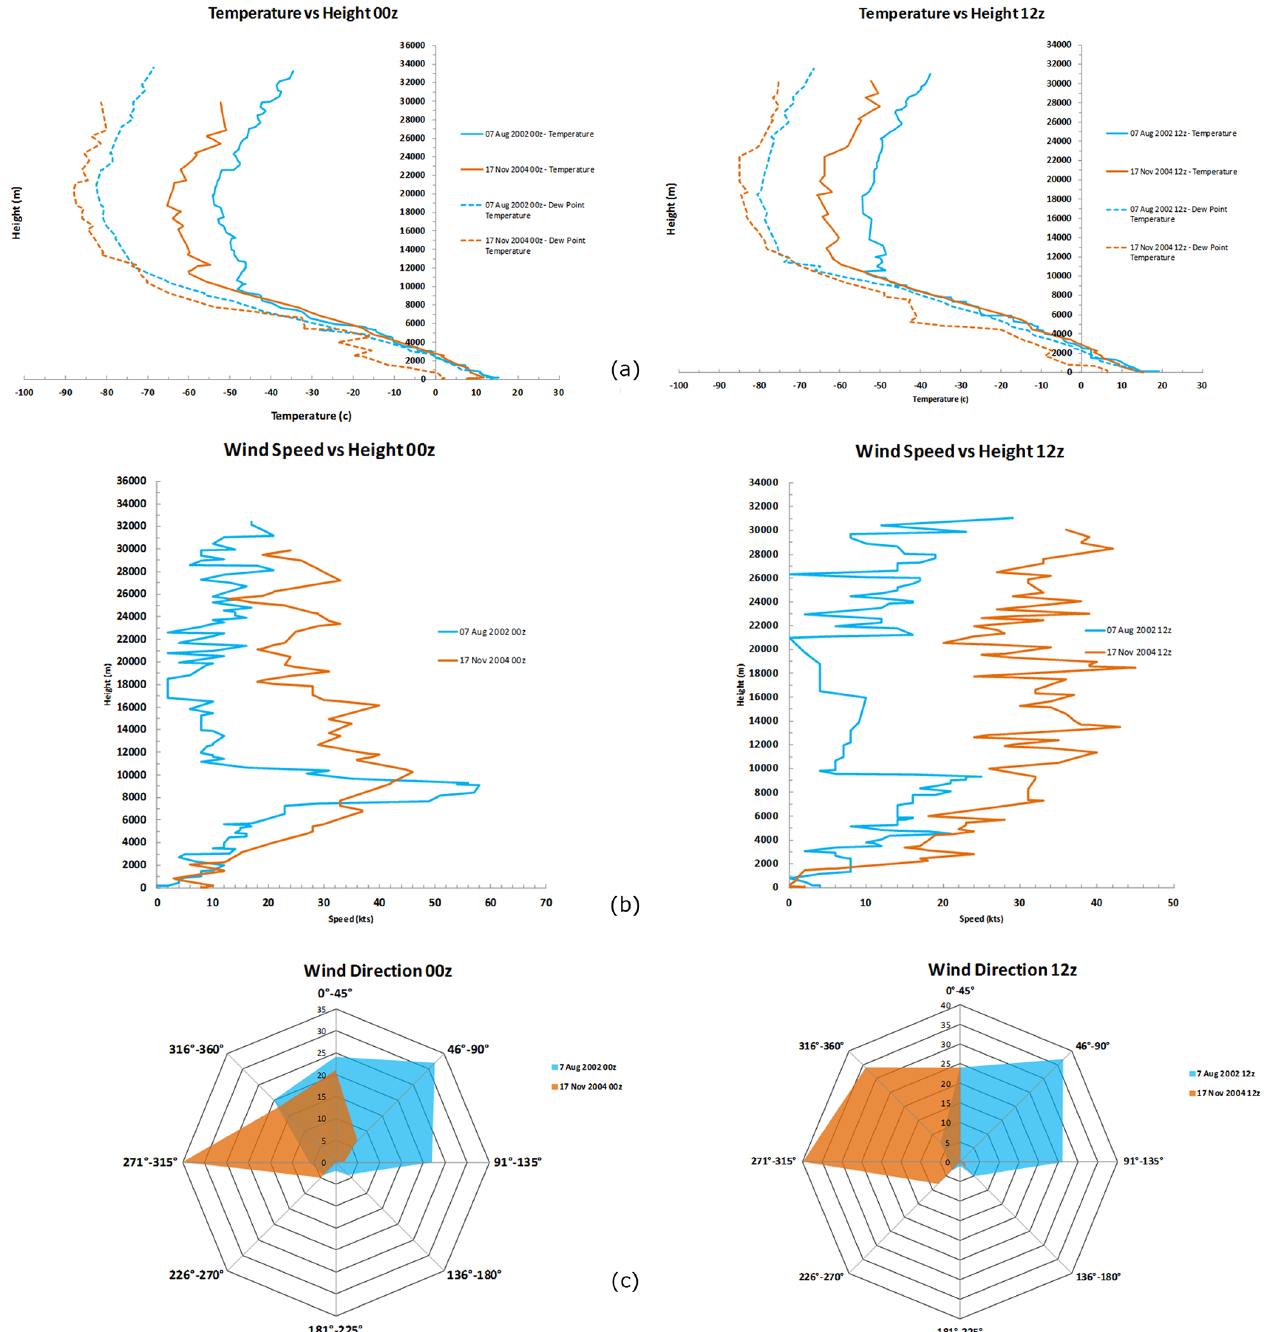
Figure 2. Atmospheric soundings used in the present study in comparison to the Petropoulos et al. (2009c) study for temperature (a, b) , wind direction (c, d) and wind speed (e, f)